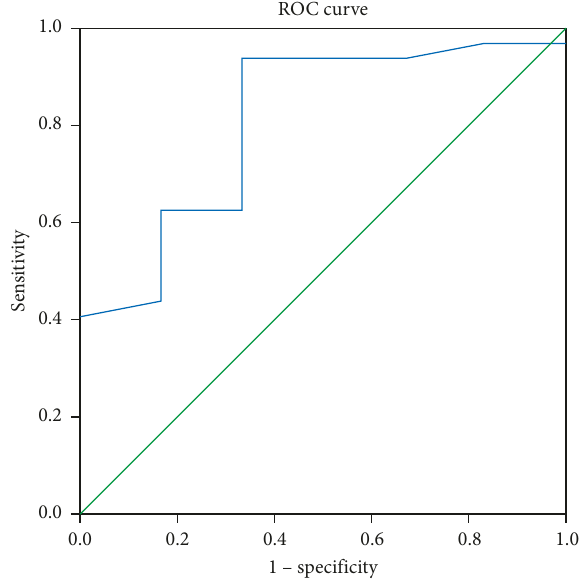
Figure 3: ROC curve for preoperative ACD in relation to the postoperative BCVA at 3–6 months. ROC: receiver operating characteristic; ACD: anterior chamber depth; BCVA: best-cor- rected visual